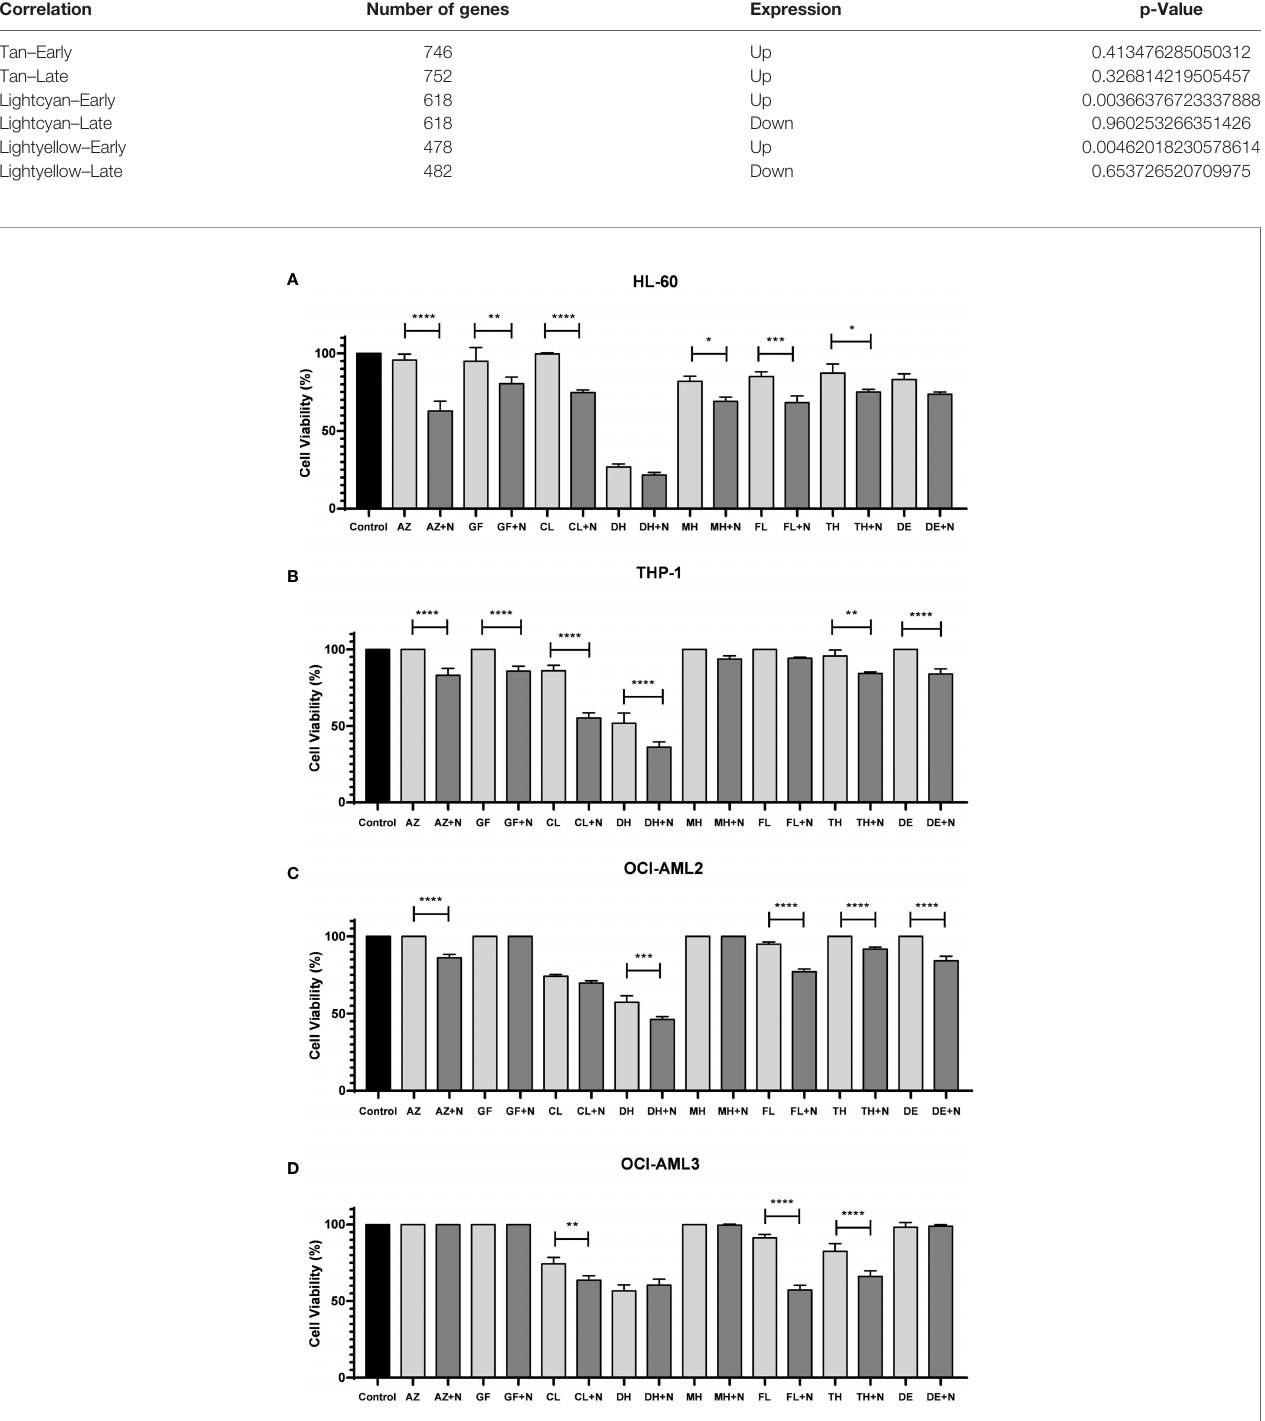
TABLE 2 | Correlation of the patient ’ s ranked genes with modules of experiment 1.